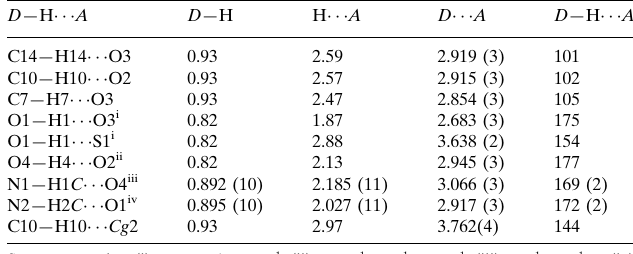
Related literature